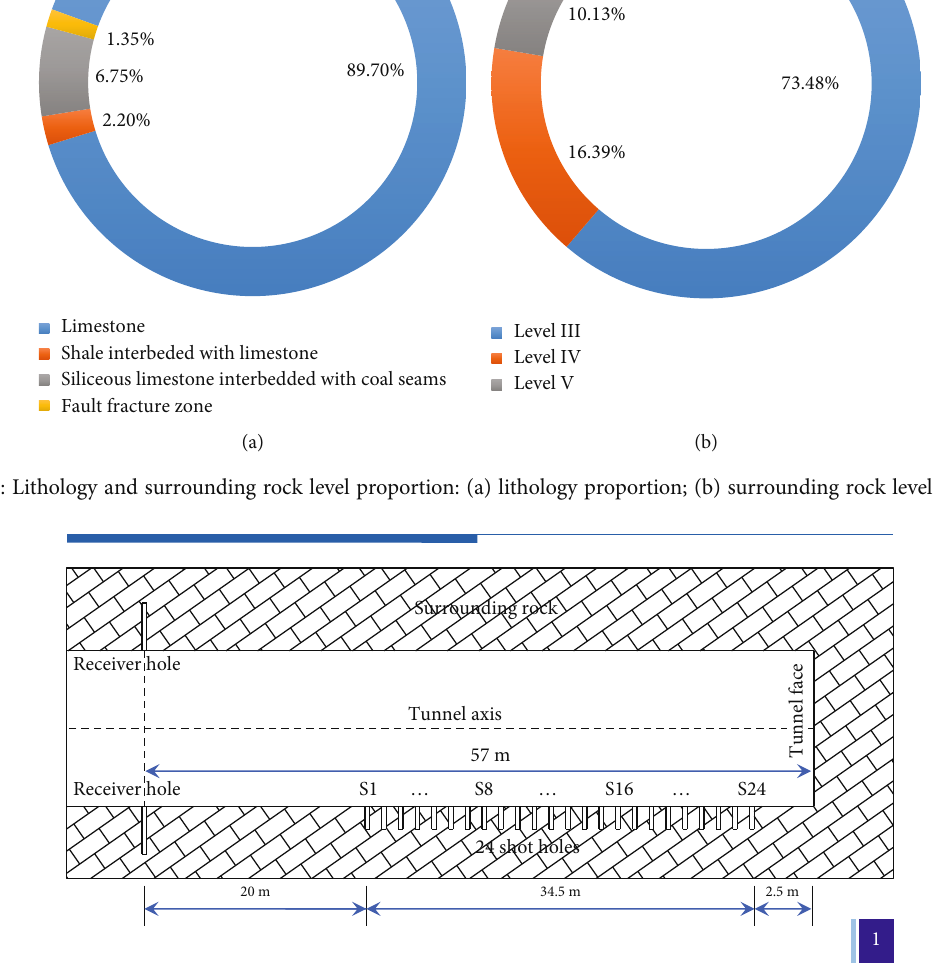
Figure 3: Acquisition layout of TSP advance geological